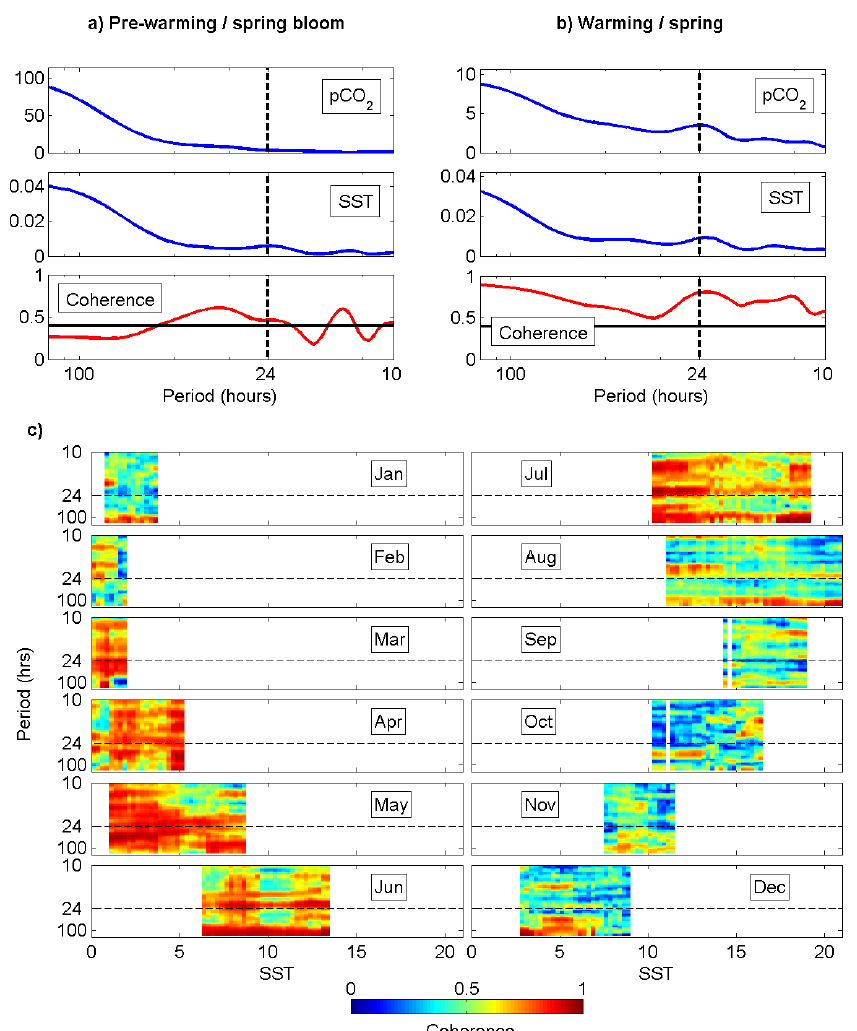
Fig. 3. Spectral analysis of p CO 2 and SST data from the CARIOCA buoy. Power spectra of p CO 2 and SST and their coherence are shown for two periods: (a) the pre-warming/spring bloom period and (b) the warming period (see Fig. 1a grey boxes). The dashed line on each plot indicates the 24h period, and the horizontal solid line on the coherence plots shows the 5% significance level based on the degrees of freedom of the cross-spectral estimators. The coherence between p CO 2 and SST is plotted as a function of SST in monthly composites (c) , illustrating the temporal evolution of the coherence. The colour scale indicates the level of coherence between p CO 2 and SST, and the dashed line shows the 24h period. High coherence at the 24h period occurs only when the water is